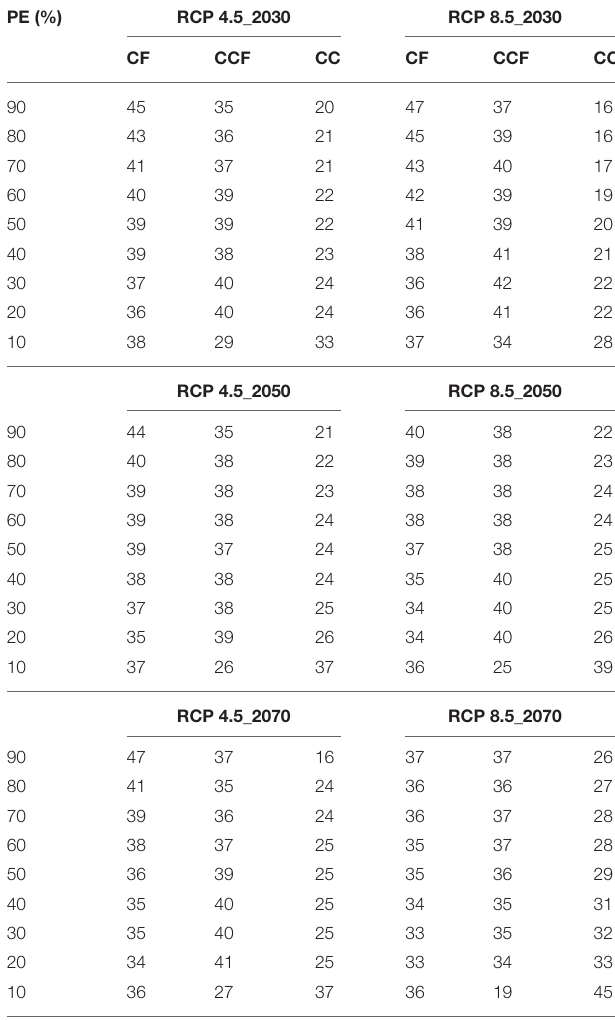
TABLE 4 | Percent of cells in each agroecological class in the dryland region of the Inland Pacific Northwest (crop/fallow (CF), annual crop/fallow transition (CCF) and continuous cropping (CC)) for the future periods under 2 representative concentration pathways (RCP) at different probabilities of exceedance